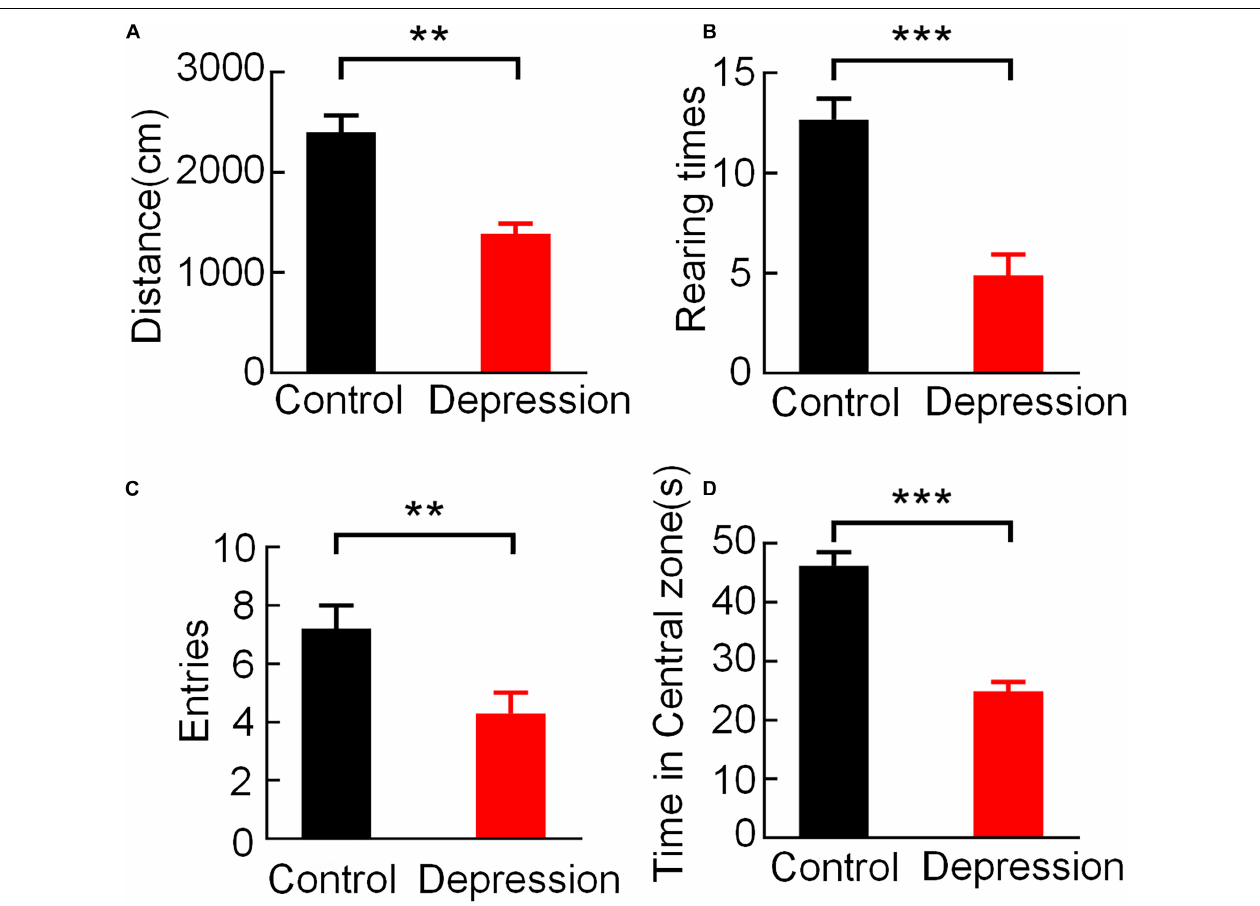
FIGURE 2 | Comparison of behavioral performance in the OFT between the control and depression groups. (A) Comparison of the averaged movement distance. (B) Comparison of the averaged rearing times. (C) Comparison of the averaged entries of the central zone. (D) Comparison of the averaged time spent in the central zone. Error bars indicate SEM. Independent sample t -test, ** p < 0.01, *** p <